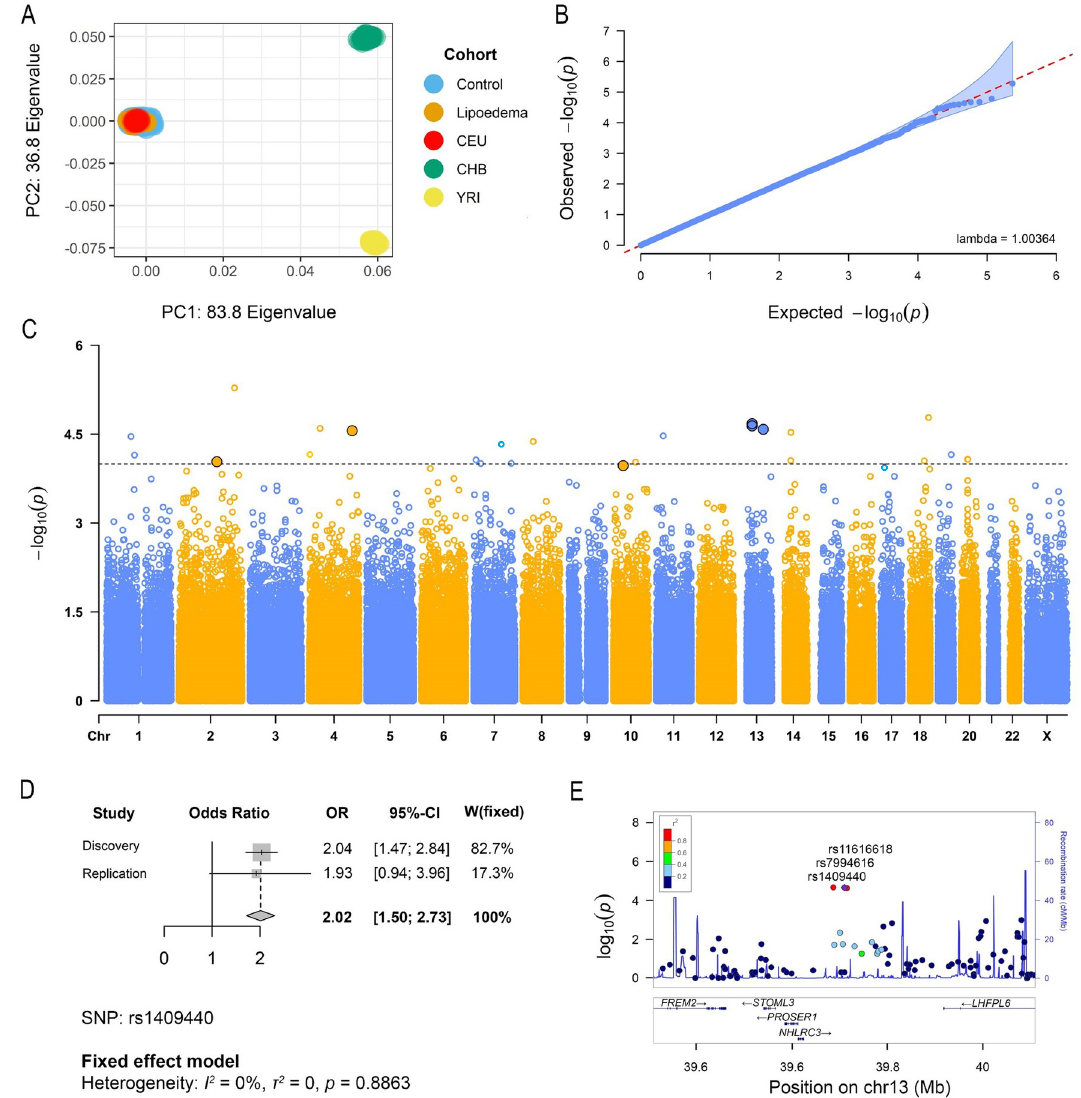
Fig 2. Results of the ‘UK Lipoedema’ discovery cohort Genome-Wide Association Study (GWAS) and meta-analysis. (A) Plot of the first two principal components from the PCA performed on the GWAS (lipoedema cases and controls) samples and the HapMap individuals. (B) Quantile–Quantile plot of GWAS samples showing no genomic inflation. (C) Manhattan plot of the genome-wide P - values (in–log 10 scale) of association with lipoedema in the discovery cohort. The association was tested using logistic regression analysis. The highlighted SNPs (dots with black outline) were tested in the replication cohort and have P meta < 1 x 10 − 4 and same direction of effect for both studies. (D) Forest plot of the chromosome 13 rs1409440 SNP meta-analysis pooled odds ratios and 95% confidence intervals. (E) Regional plot of the top three SNPs (rs1409440, rs7994616, rs11616618) from the meta-analysis in one distinct genomic locus on chromosome 13 near the LHFPL6